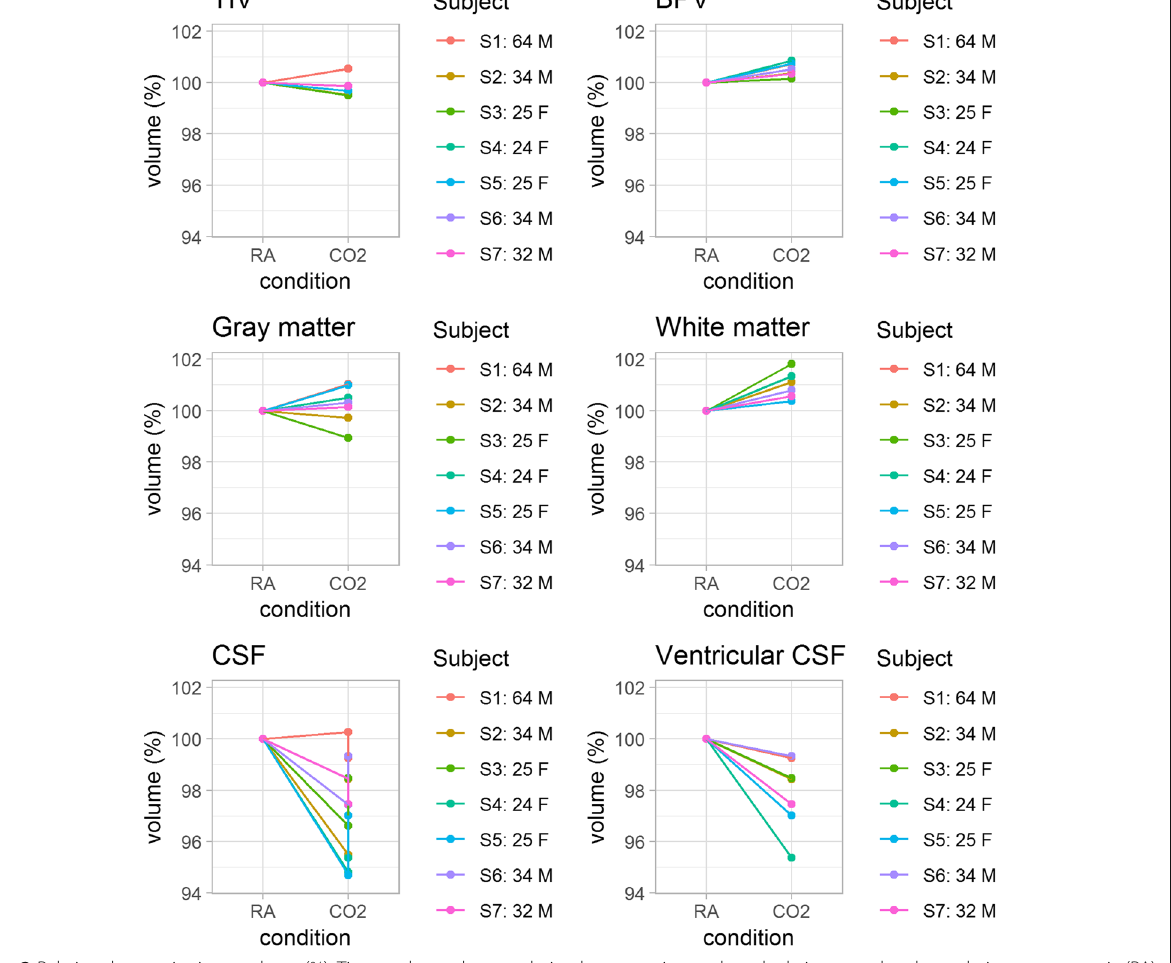
Fig. 2 Relative changes in tissue volume (%). Tissue volume changes during hypercapnia are plotted relative to each volume during normocapnia (RA) (set to 100%) per subject. Subject 1 showed an increase in all measured volumes, which resulted in an estimated intracranial volume increase of 9mL during hypercapnia (top left image). BPV Brain parenchymal volume, CSF Cerebrospinal fluid, F Female, M Male, TIV Total intracranial